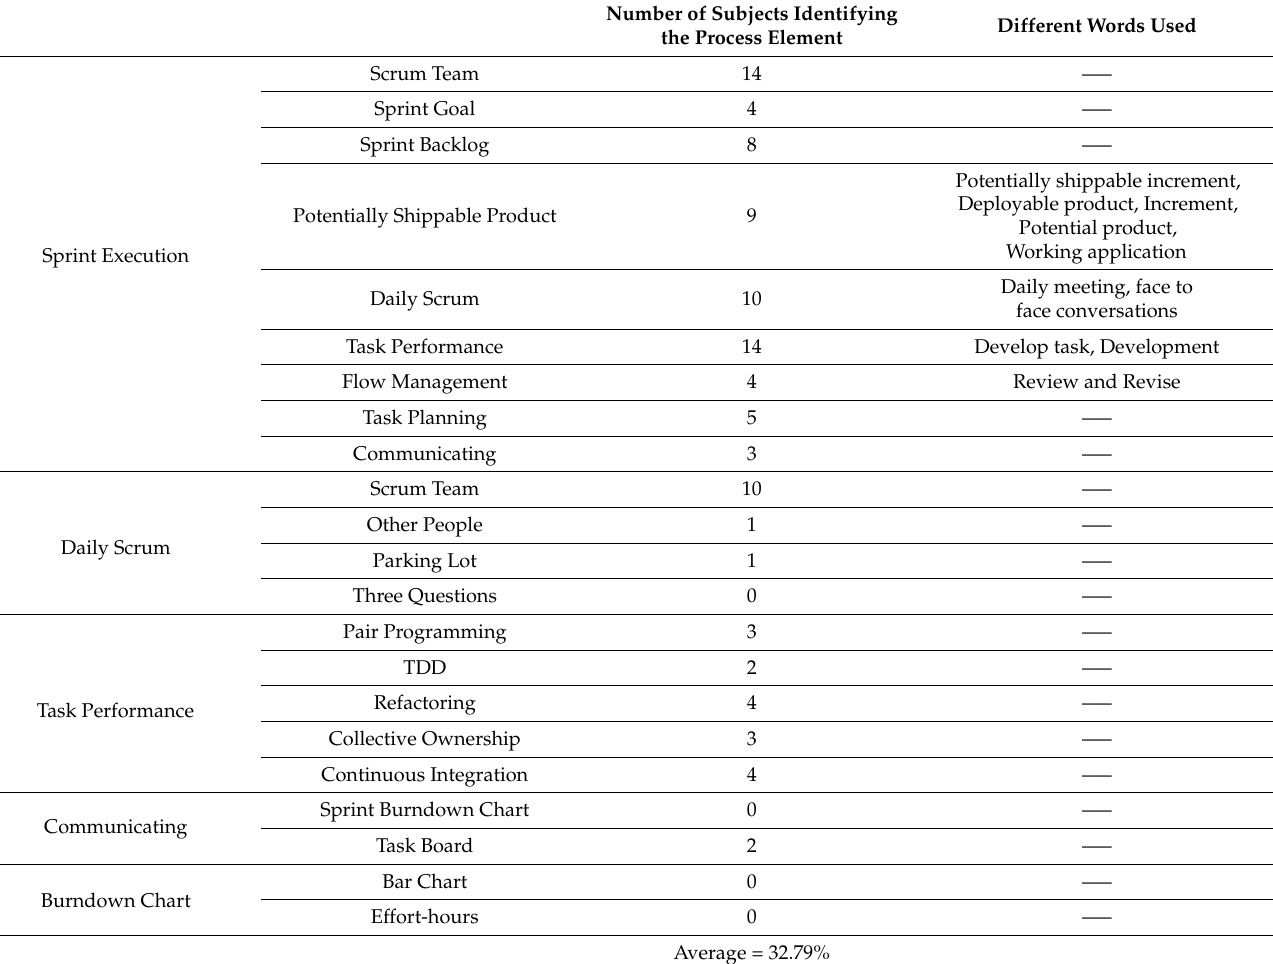
Table A9. Comparison of the process elements identified in the two